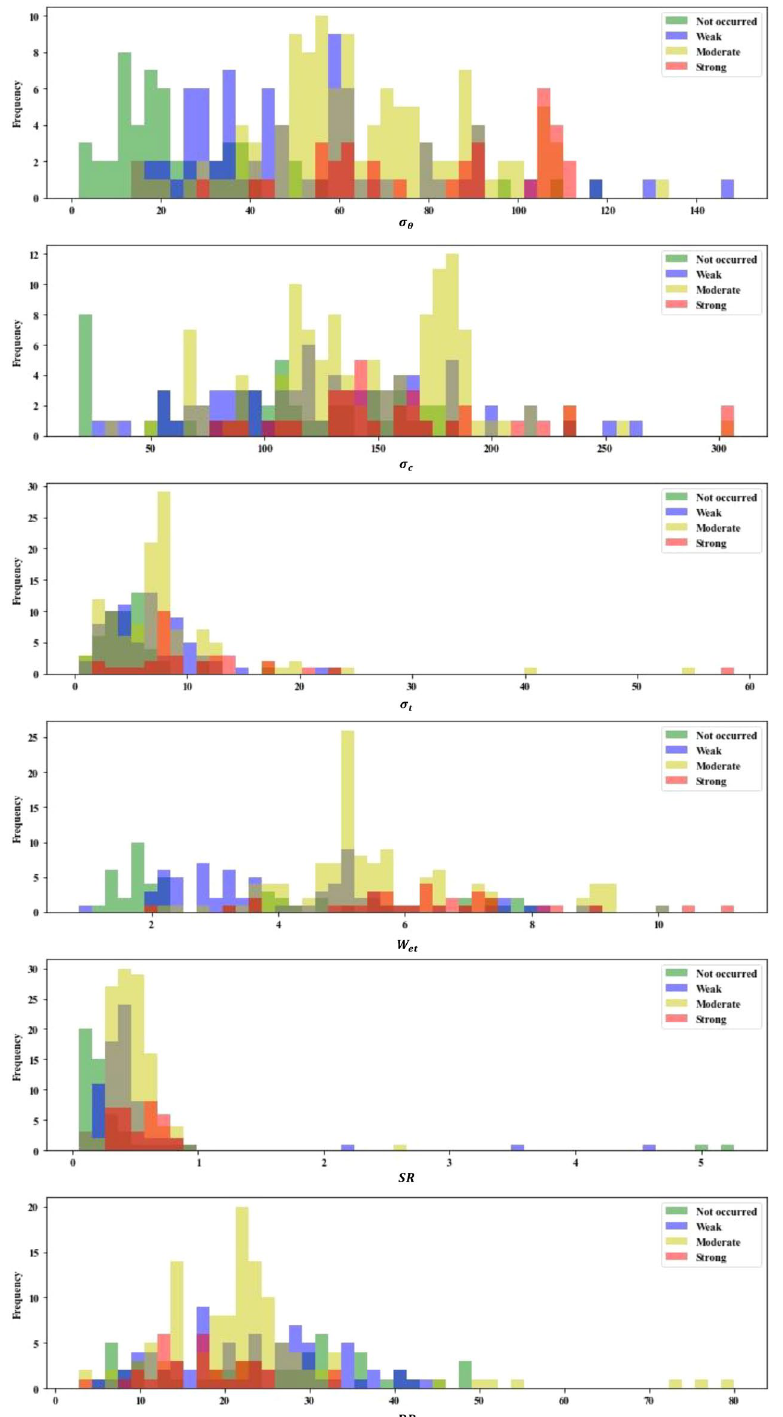
Figure 2. Overlaid histograms of each feature in the rockburst